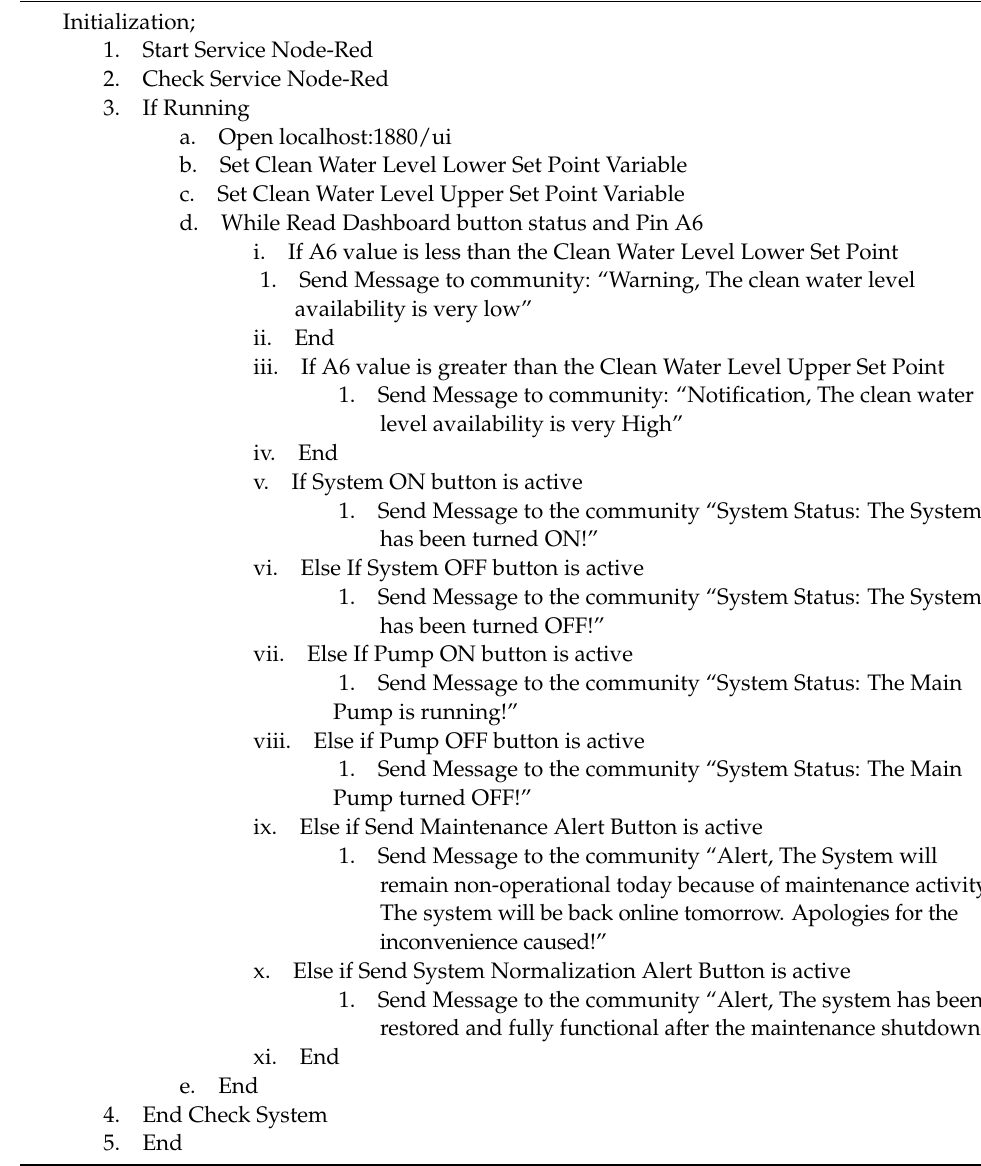
Algorithm 3: Alert System for